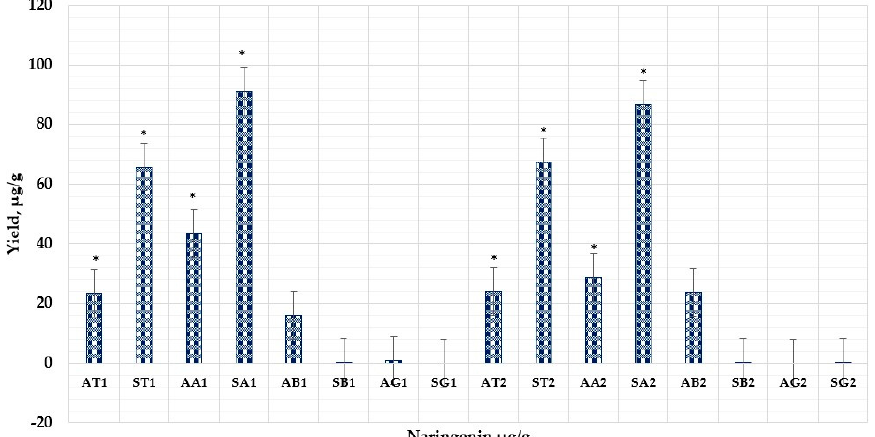
Figure 9. The quantitative yield of naringenin using excipients (1%). First letter demonstrated fruit parts (A—lbedo; S—segmental membrane); second letter (T—control sample; A— α -CD; B— β -CD; G— γ -CD); numbers (1–50% solvent v / v ; 2–70% solvent v / v ). AA1 p < 0.05 vs. AT1; AA2 p < 0.05 vs. AT2; SA1 p < 0.05 vs. ST1; SA2 p < 0.05 vs. ST2; AA1 p < 0.05 vs. AA2; AB2 p < 0.05 vs. AB1. * Results are means ± SD ( n = 3).